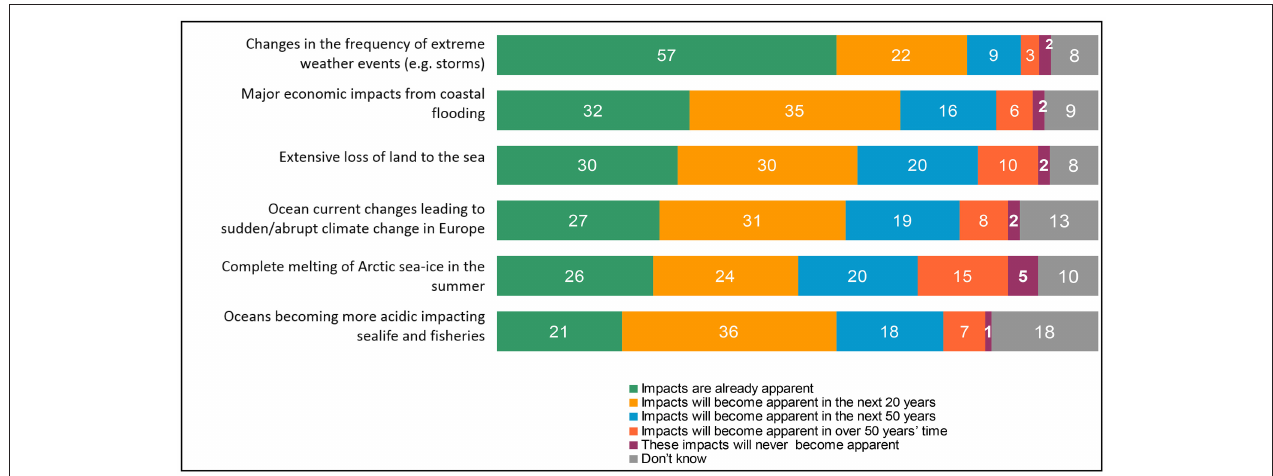
FIGURE 7 | Results to the multiple choice questions “When, if at all, do you think the following impacts of climate change on the coastline and seas of Europe will become apparent?” Sample = all 10 countries combined; N = 10,106